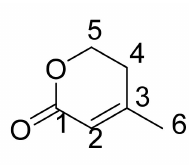
Figure 2. Chemical structure of